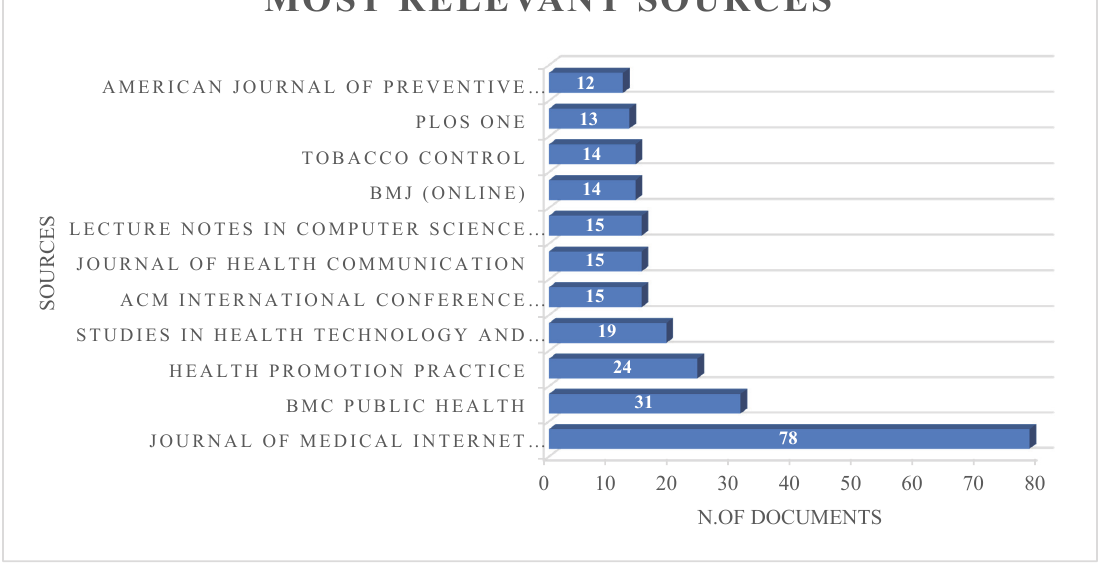
Fig. 3. Most Relevant